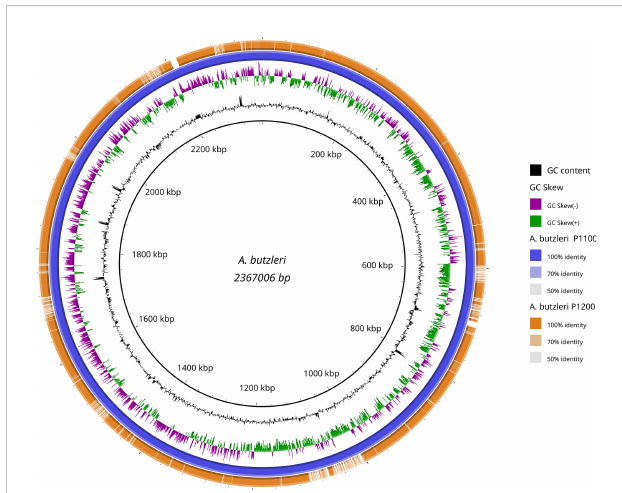
FIGURE 3 Blast Ring Image Generator (BRIG) generated graph depicting homologous chromosome segments of A. butzleri P1100 (reference) and P1200. A. butzleri P1100 was chosen as reference (inner black circle) and is additionally shown in the second outer circle (blue). The outermost orange ring shows the homology of A. butzleri P1200 compared to A. butzleri P1100 based on BLASTn+ analysis. Additionally GC content (black) and genomic GC skew (purple/green) are also shown in the fi gure.